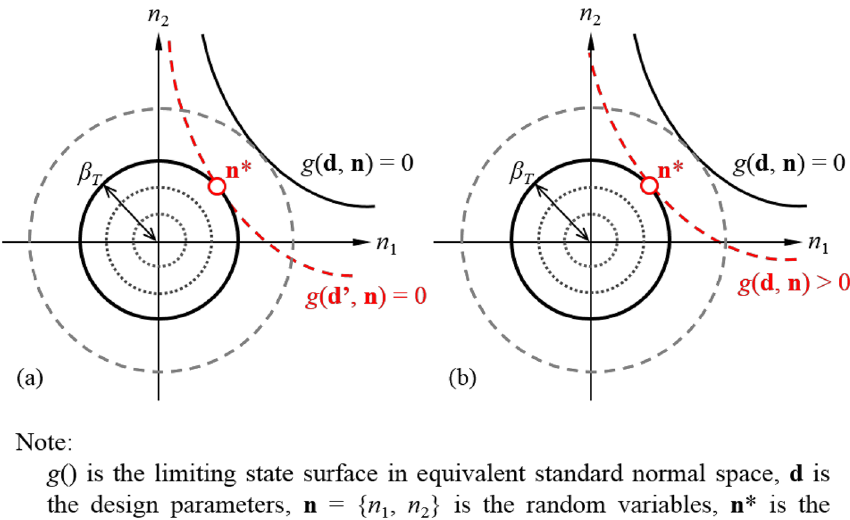
Figure 3. Determination of design point for target reliability index: ( a ) First-order reliability method; ( b ) Target reliability